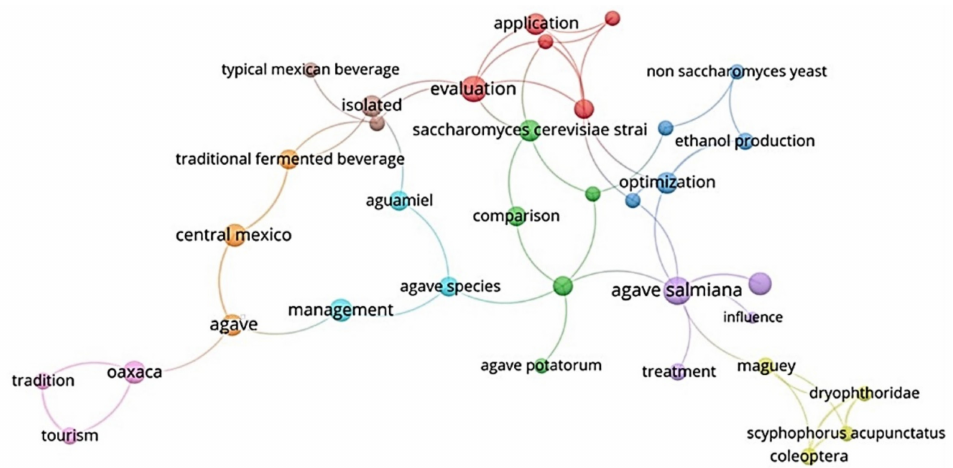
Figure 1. Clusters representing different research topics reported in the literature. The red cluster • is related to biotechnolog- ical applications in traditional fermented beverages; the green cluster • represents studies related to the mescal production; the blue cluster • are those on the application of yeasts through the production of traditional fermented beverages; the olive cluster • includes studies on pathogens affecting the development of Agave ; the purple cluster • comprises the research on environmental factors influencing the fermentation process; the light blue cluster • are studies on management practices of Agave and sap extraction; the orange cluster • indicates the reports on the presence of traditional fermented beverages in central Mexico, mainly pulque and mescal ; the brown cluster • shows the research that has been directed to maize beverages and the possible probiotic features associated with this microbiota; the pink cluster • shows the importance of cultural groups of related to production of fermented beverages, but it is only related with mescal